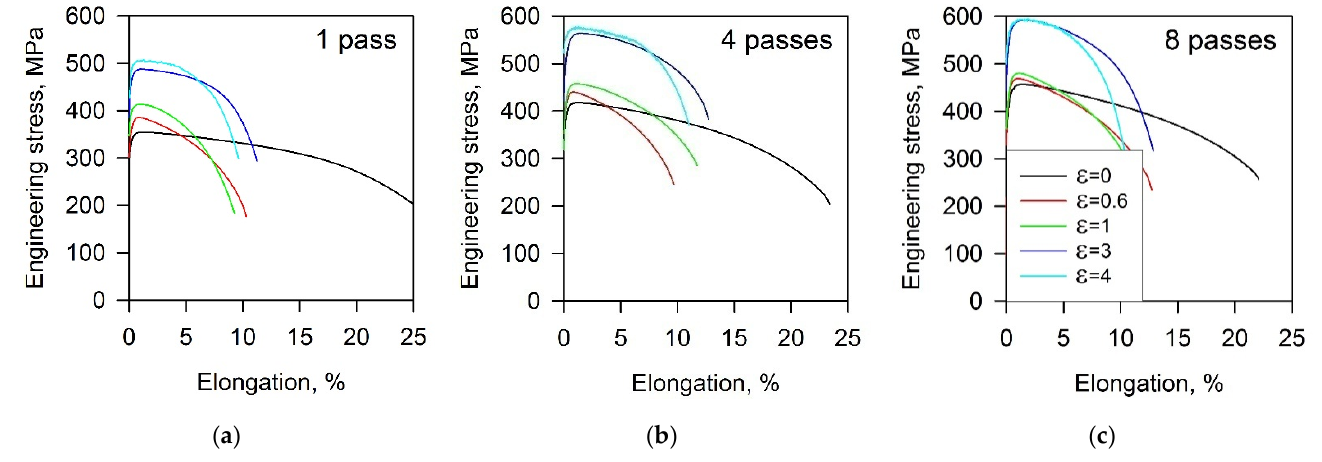
Figure 5. Tensile stress—elongation curves for a Cu-Cr-Zr alloy subjected to 1 ( a ), 4 ( b ), and 8 ( c ) passes of ECAE-Conform followed by cold rolling to the indicated strains ( ε ).